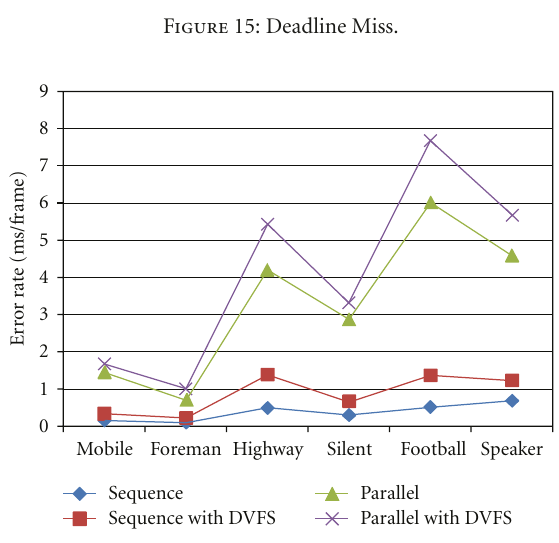
Figure 16: Error